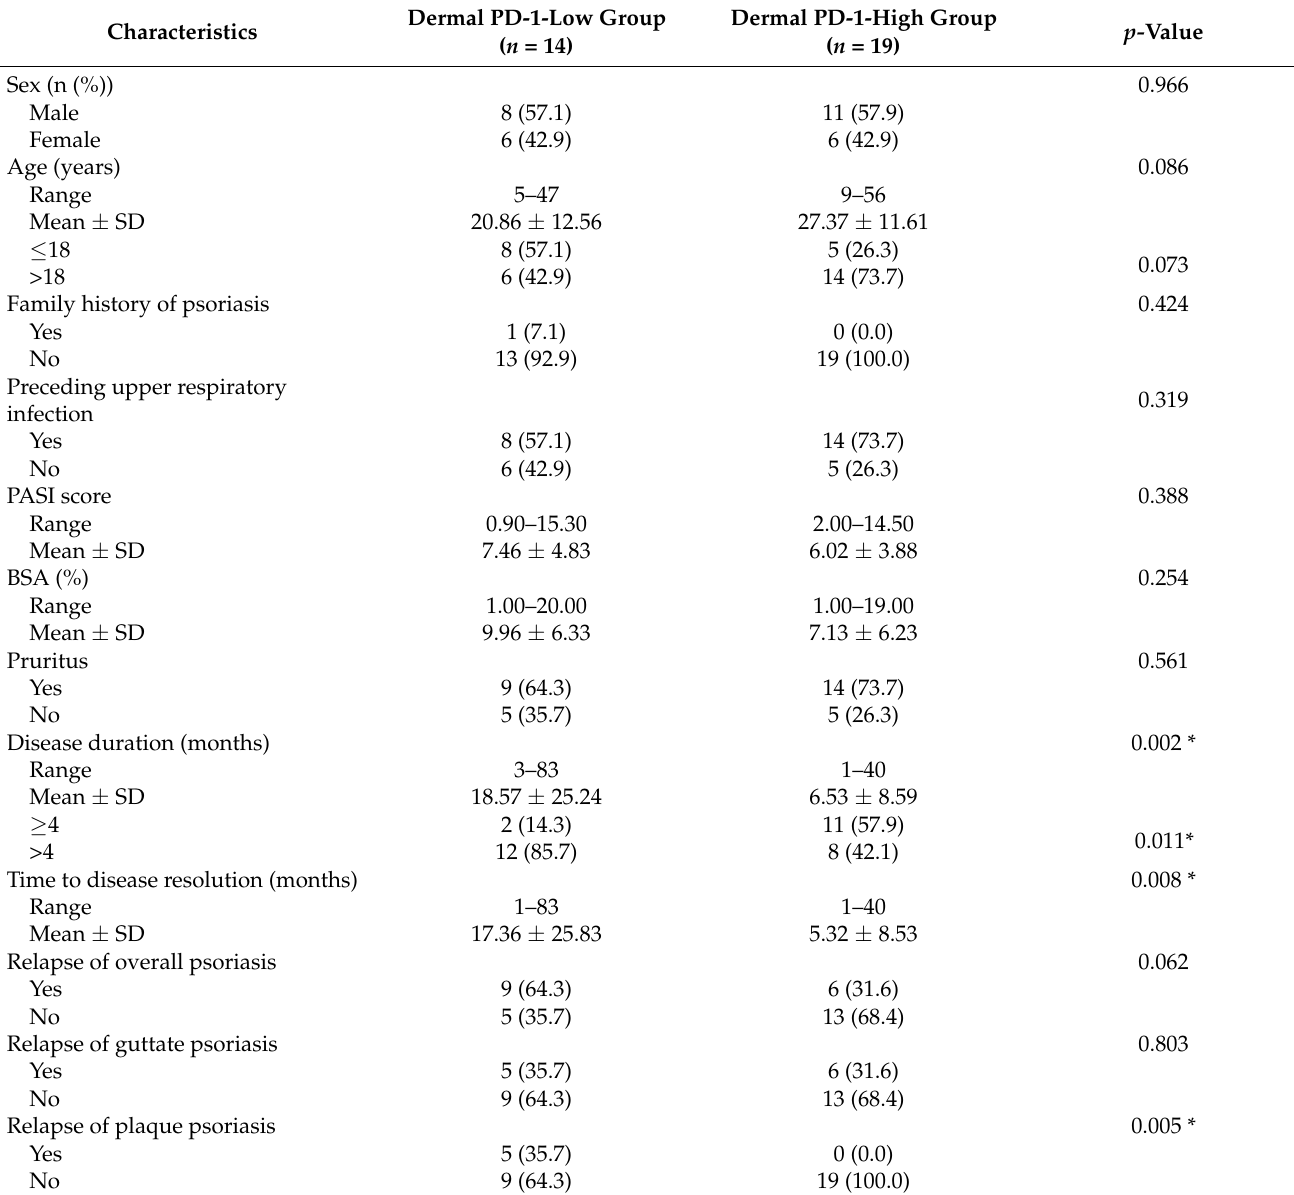
Table 3. Clinical characteristics of patients with guttate psoriasis according to the dermal expression level of PD-1.